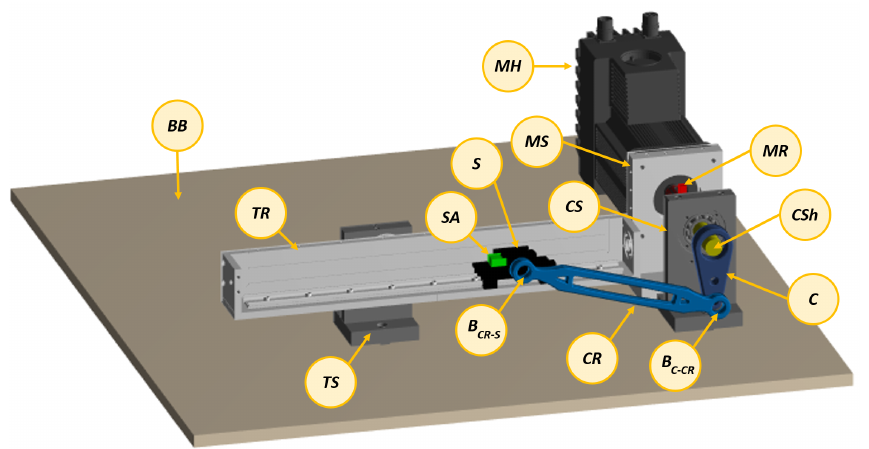
Figure 4. The slider-crank: multibody